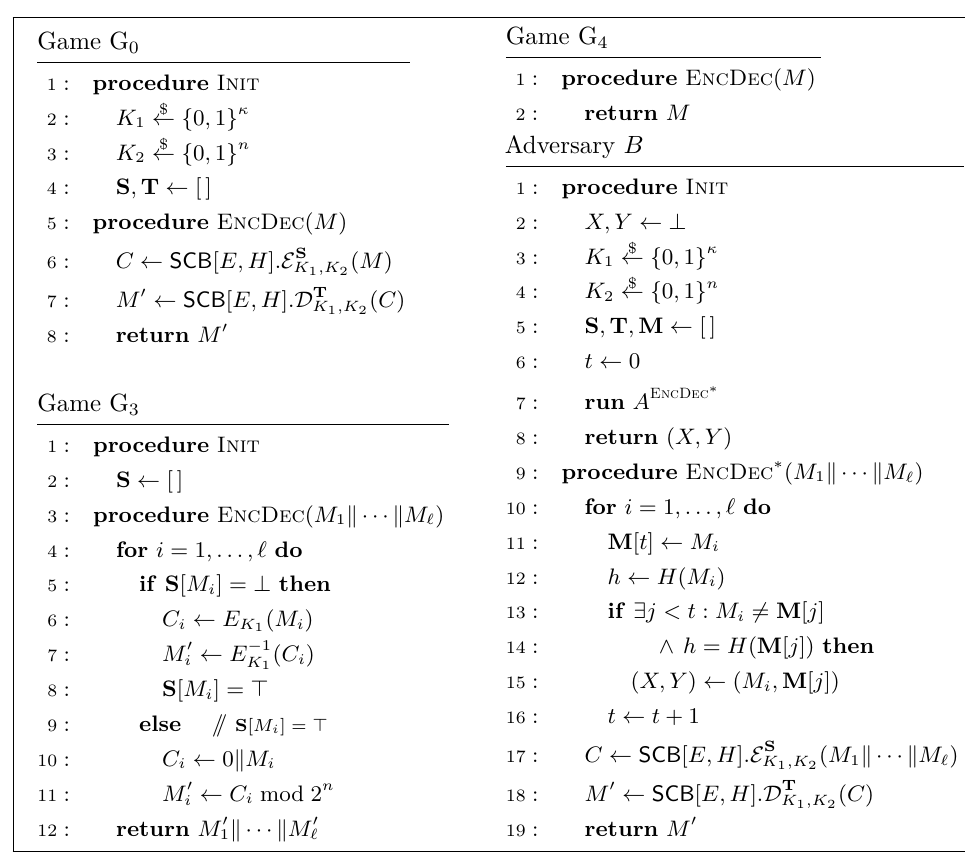
Figure 8: Games G 0 , G 3 , G 4 and adversary B for the proof of Theorem